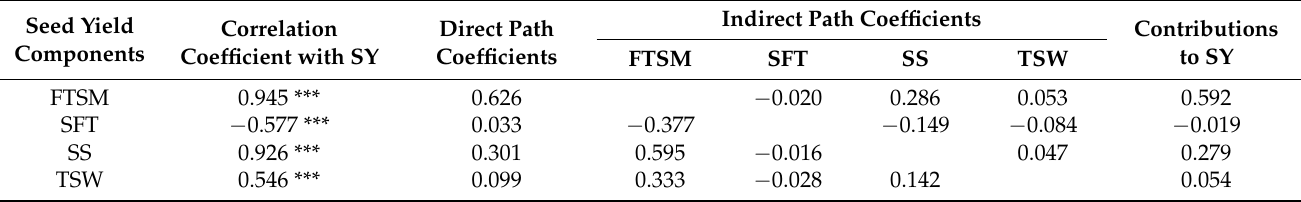
Table 3. Correlation coefficients, path coefficients and contributions of yield components to the seed yield of Cleistogenes songorica ( n =